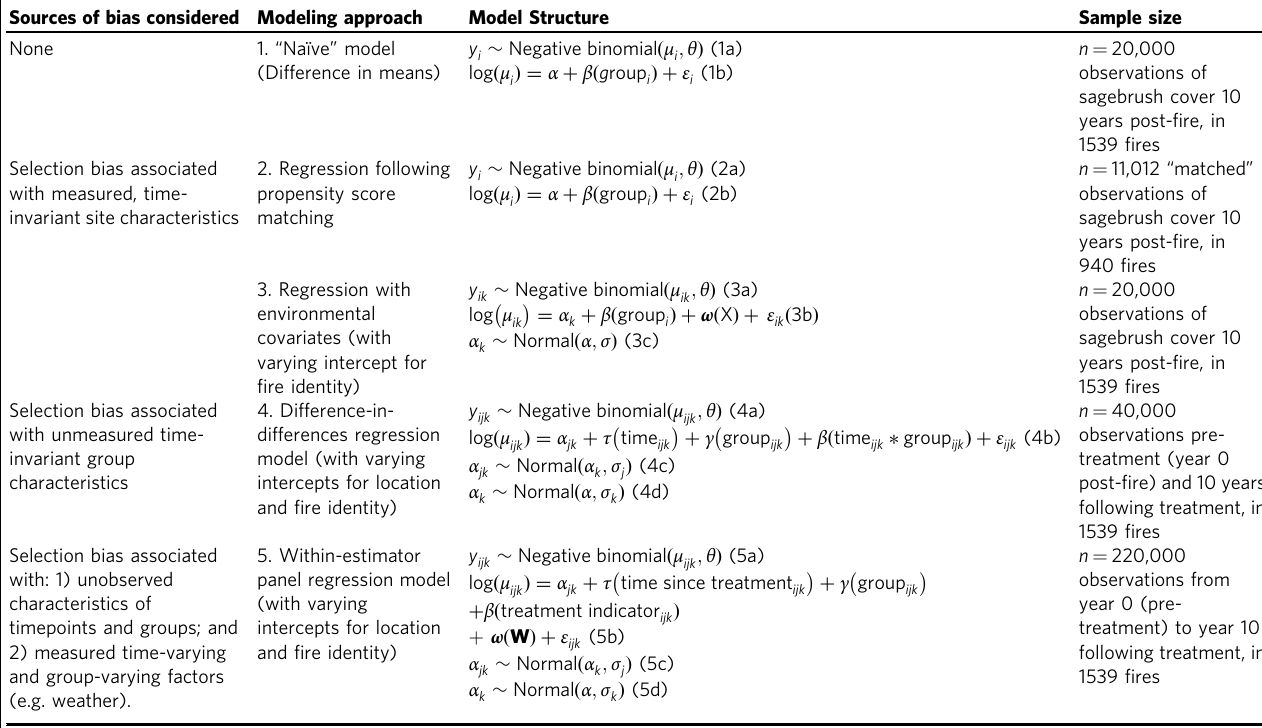
Table 1 Summary of model structures used in comparative analysis of treatment effectiveness. Sources of bias considered Modeling